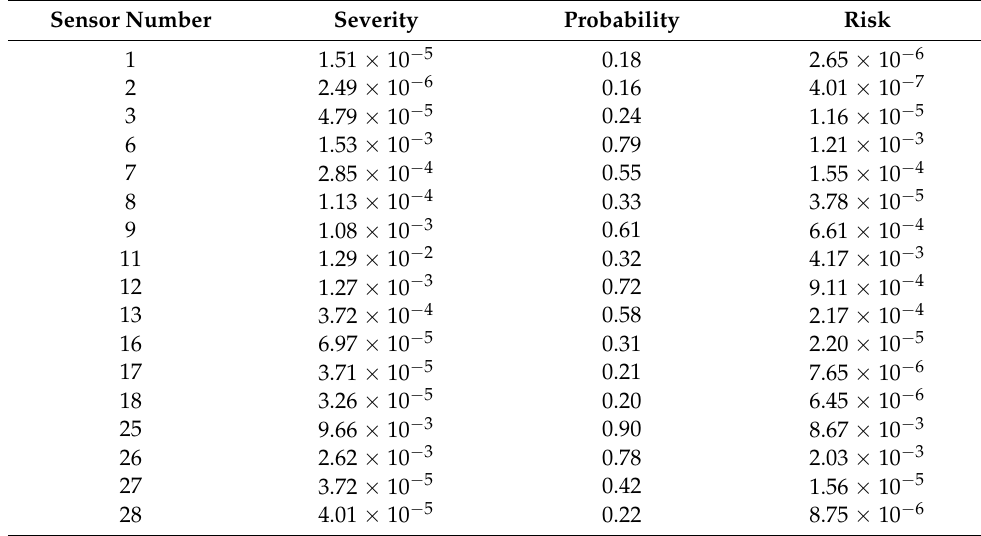
Figure 4. Calculation results of the risk value of sensors. Table 4. Risk value calculation